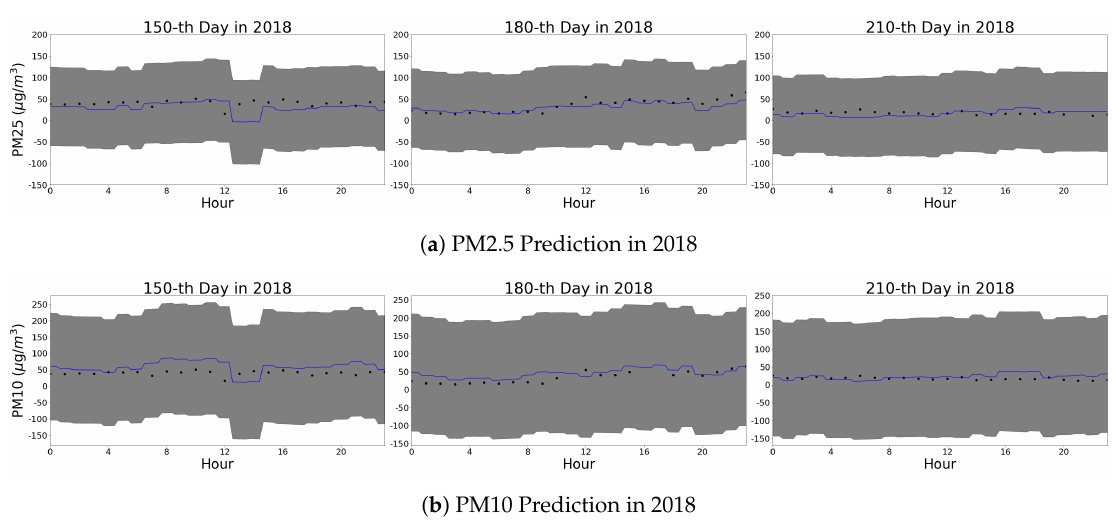
Figure 6. One day prediction results of our GPR model at grid location of (127.040207, 37.543796). (Black dot: observed, Blue line: predicted, Grey area: 95% confidence